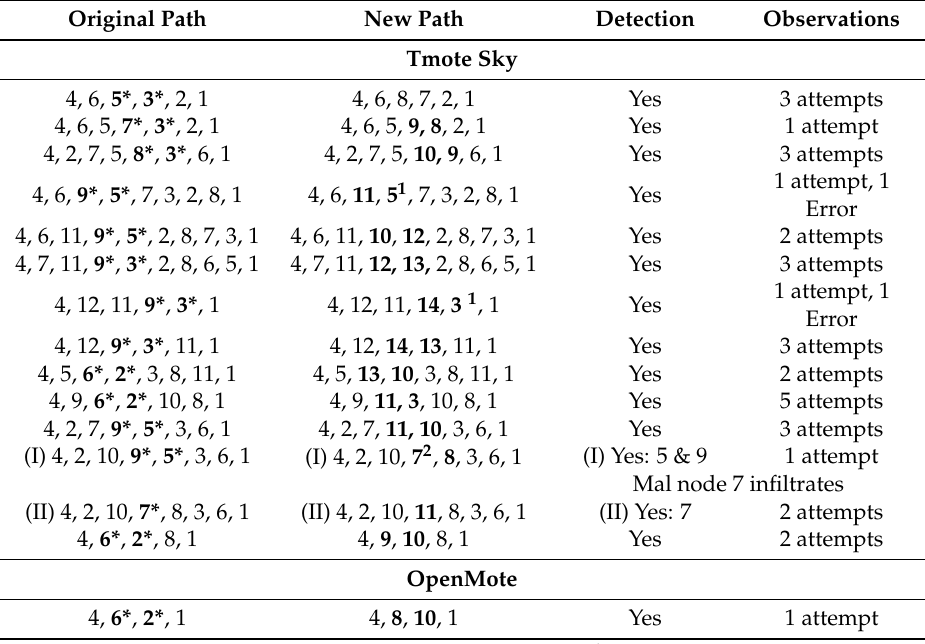
Table A3. Accuracy check for collaborative